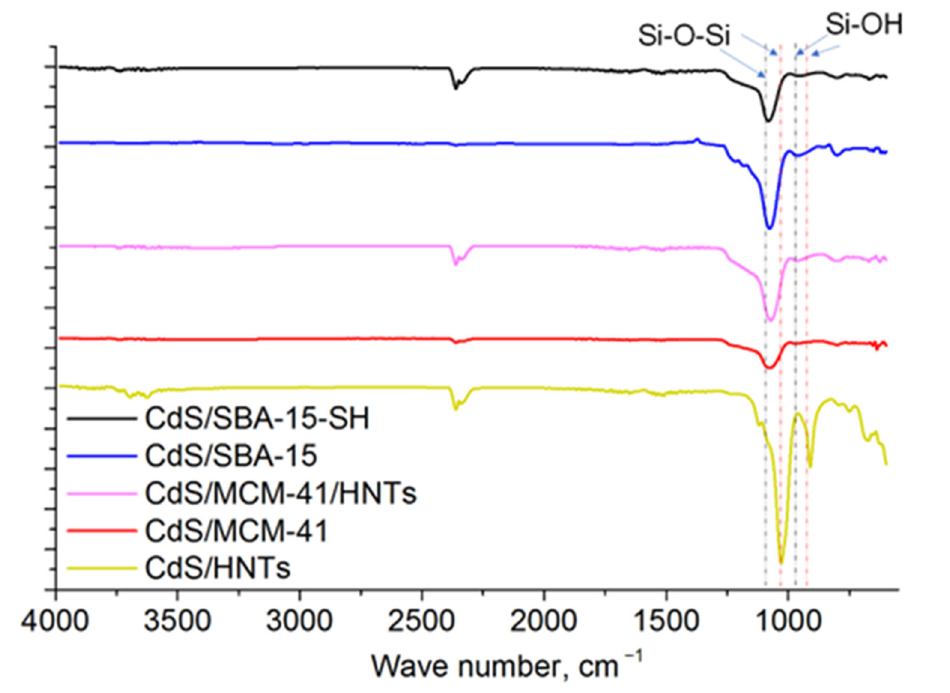
Figure 4. FT-IR spectra of CdS-based mesoporous materials.